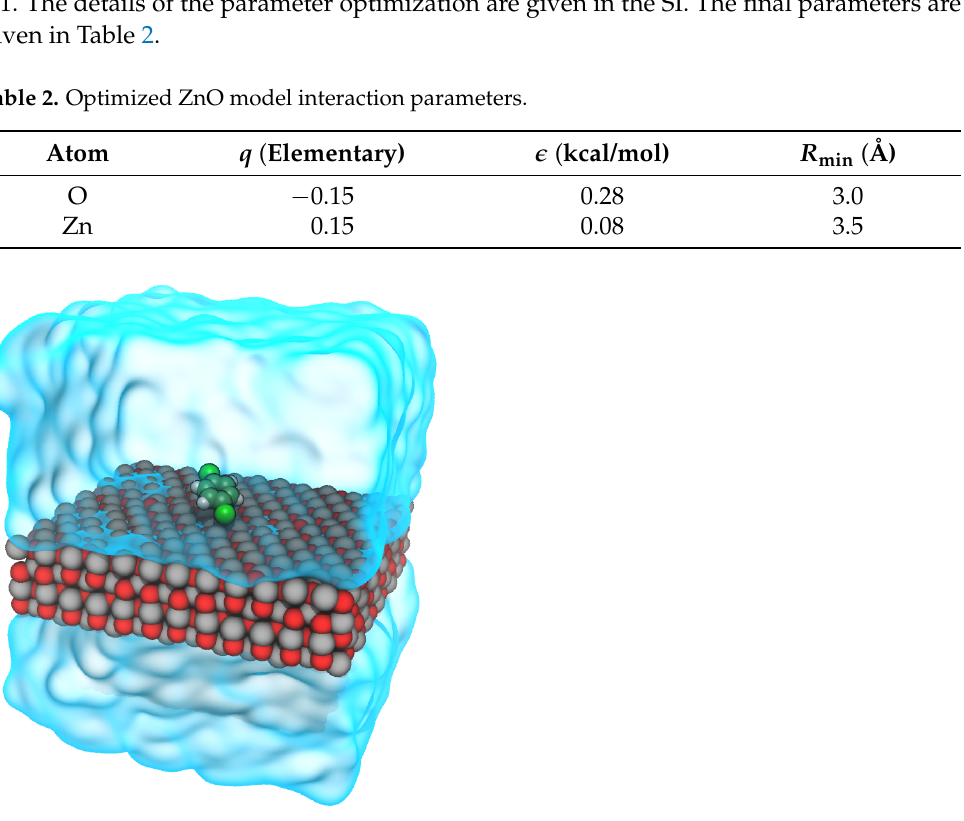
Figure 2. Exemplary model of a simulation system, including an effectively infinite ZnO slab, an organochlorine molecule, and water. Atom color scheme: H, white; C, dark green; O, red; Cl, bright green; Zn, gray. Although the simulations included explicit water molecules, for clarity, water is shown as a transparent blue